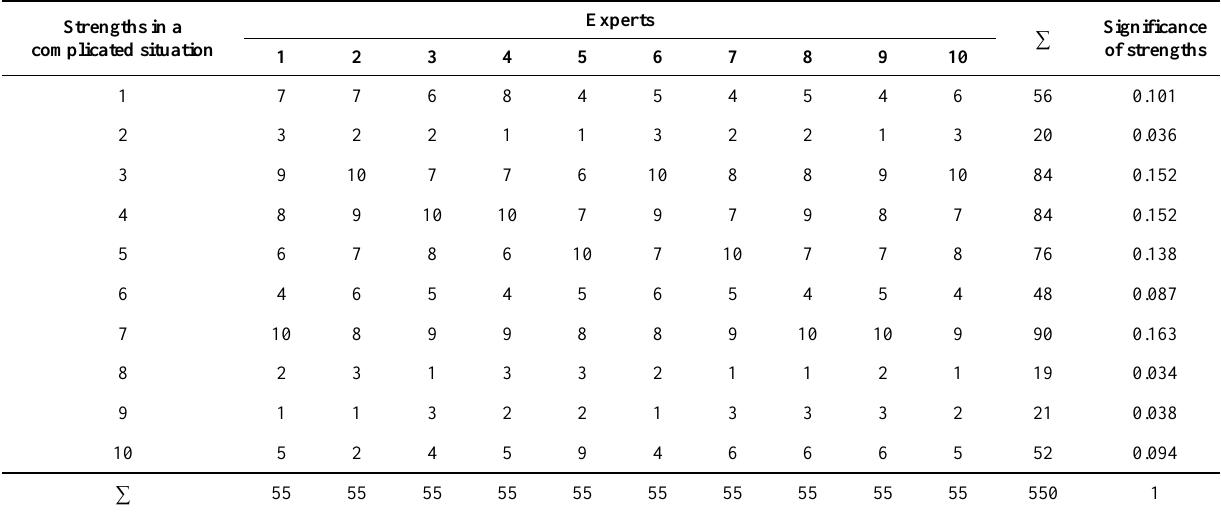
Table 1. Assessment of the strengths significance in a complicated